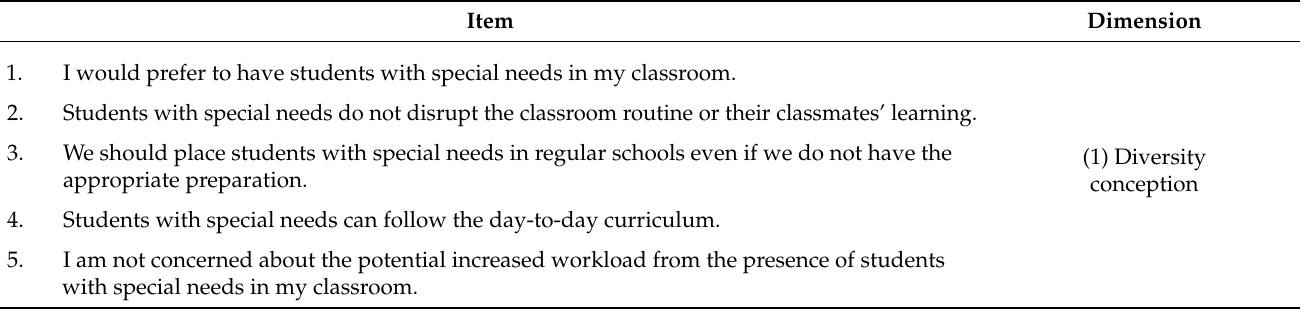
Table 1. The Evaluation of Teacher Preparation for Inclusion Questionnaire (CEFI-R)